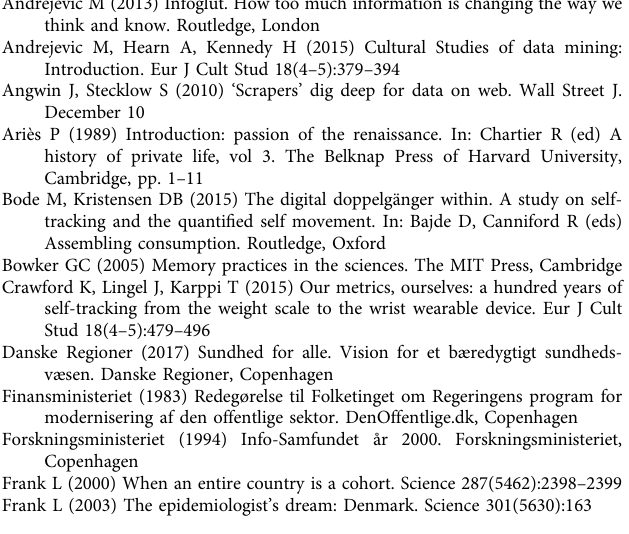
Danske Regioner (2017) Sundhed for alle. Vision for et bæredygtigt sundheds- væsen. Danske Regioner, Copenhagen Finansministeriet (1983) Redegørelse til Folketinget om Regeringens program for modernisering af den offentlige sektor. DenOffentlige.dk, Copenhagen Forskningsministeriet (1994) Info-Samfundet år 2000. Forskningsministeriet,